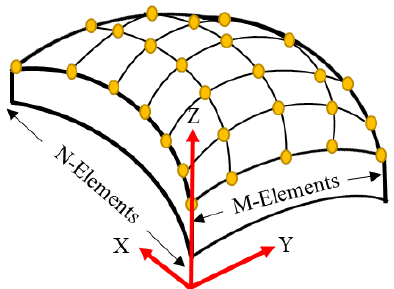
Figure 1. The schematic structure of the M × N volumetric array of point sources.